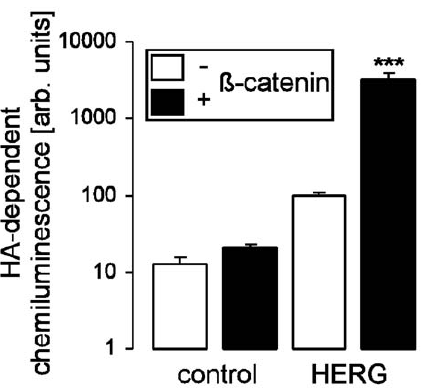
Figure 3. ß-catenin increases the surface abundance of HERG. Arithmetic means 6 SEM (n=19–56) of the normalized HA-dependent surface chemiluminescence of oocytes injected with H 2 0 (1 st bar), with cRNA encoding ß-catenin (2 nd bar), encoding HERG (3 rd bar) or encoding both, HERG and ß-catenin (4 th bar). ***indicates statistical significance (p , 0.001) from the absence of ß-catenin cRNA.